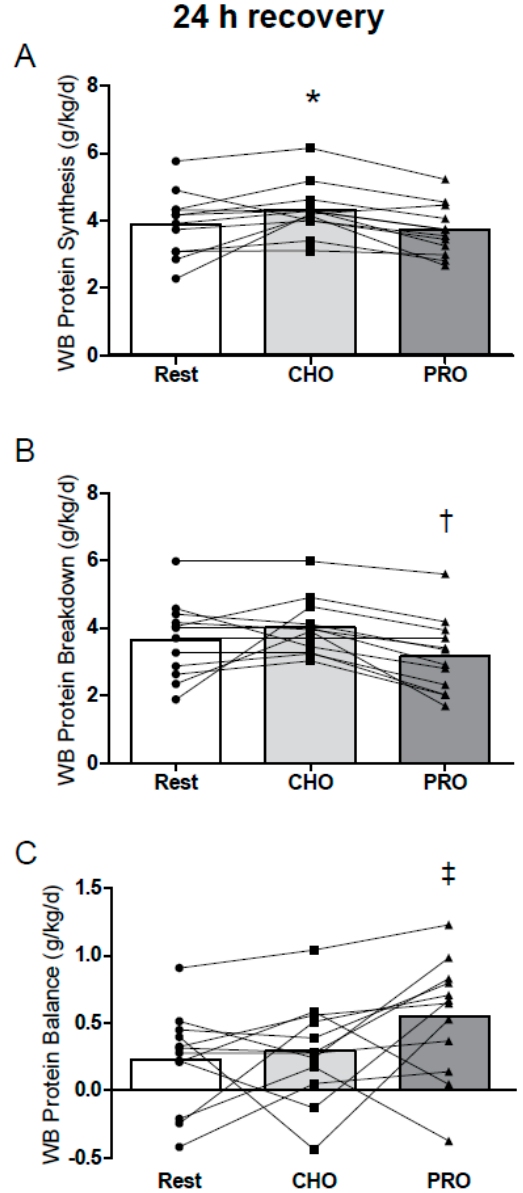
Figure 3. 24 h whole body (WB) protein synthesis ( A ), protein breakdown ( B ), and protein balance ( C ) at rest (Rest) and after whole body resistance exercise supplemented with 25 g whey protein (PRO) and isocaloric carbohydrate (CHO), calculated using the harmonic mean of urinary [ 15 N]ammonia and urea end product enrichments. Data were analysed by one-way (condition) repeated-measures ANOVA: * CHO > PRO, P = 0.017; P = 0.11 for CHO vs. Rest. Protein breakdown: † PRO < CHO, P = 0.006. Net protein balance: ‡ PRO > Rest, P = 0.036; P = 0.11 for PRO vs. CHO. Values are individual means; n = 12.